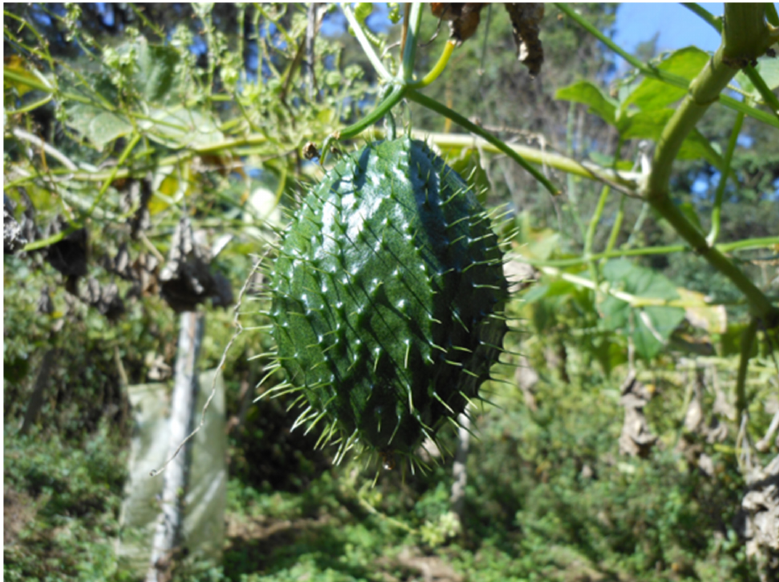
Figure 1. Fruit of Sechium edule cv. Madre Negra in horticultural maturity (22 ± 2 days after anthesis).